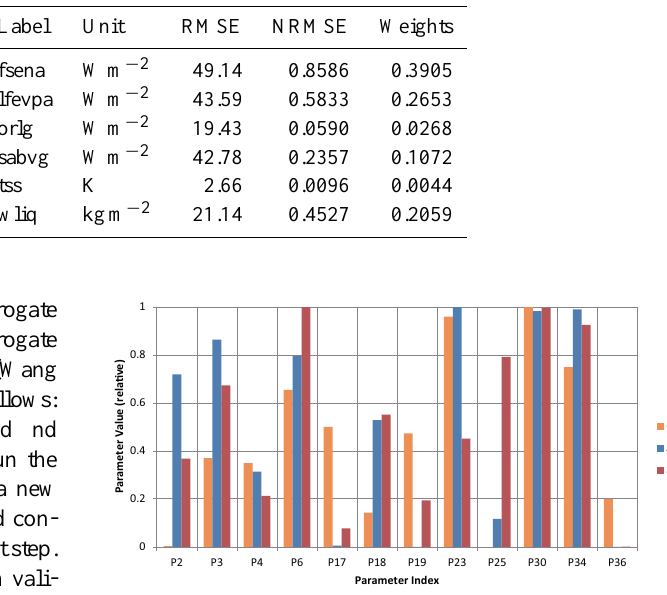
Figure 4. Optimal value of CoLM given by multi-objective opti- mization (comparing default parameter, optimal parameter given by ASMO and